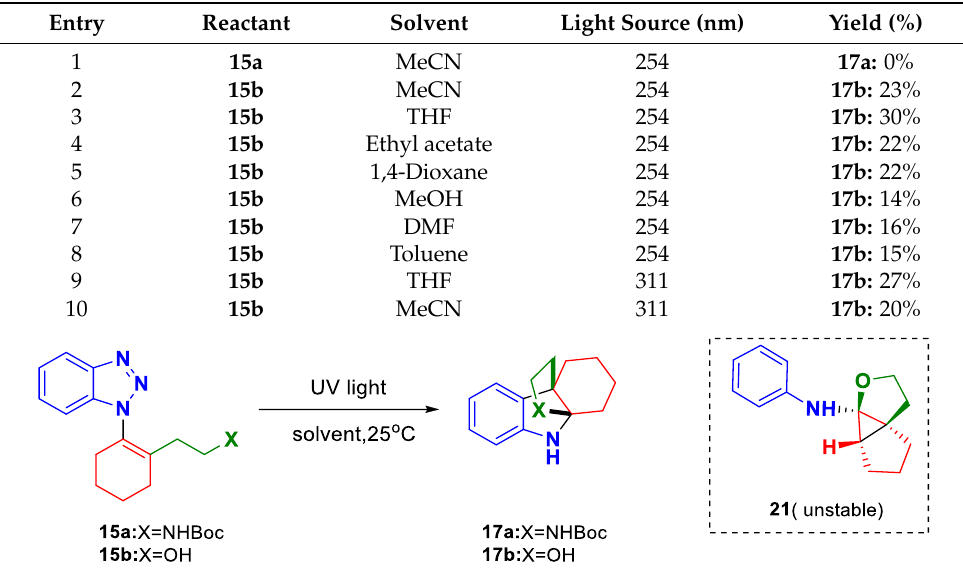
Table 1. Condition optimization of the photoreaction.